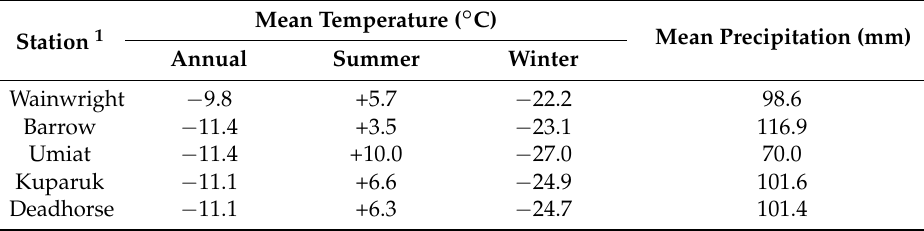
Table 1. Mean annual, summer (June–August), and winter (November–March) temperature and unadjusted annual precipitation recorded at North Slope meteorological stations for 1981–2010 base period (NCDC 2017). Some stations lack observations for portions of the base